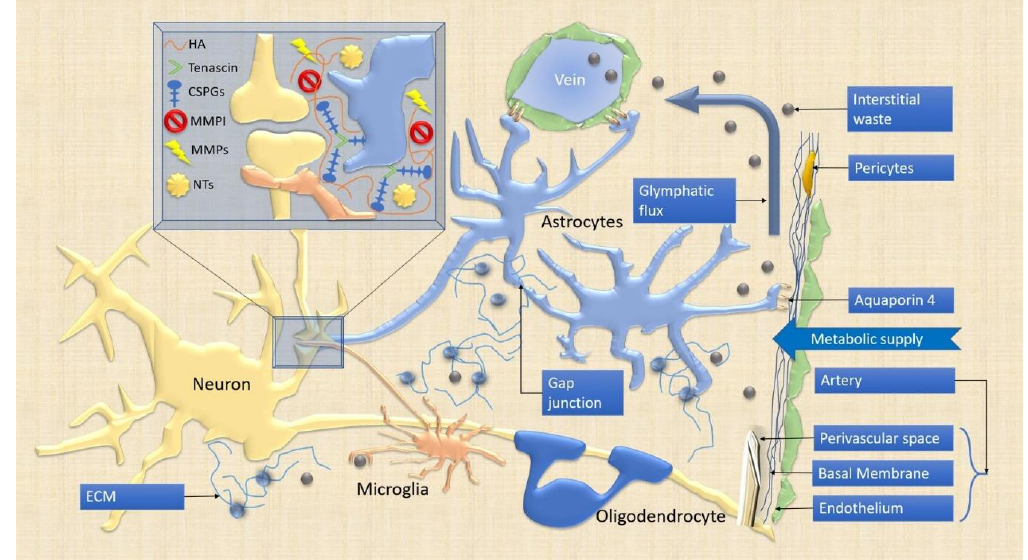
Figure 1. Schematic representation of the synaptic cleft. The main cellular and extracellular components implicated in both physiological and pathological synaptic changes are schematically represented. Oligodendrocytes ensure the correct myelination of the circuits. Microglia constantly scan the microenvironment and remove the debris. From the perivascular space of penetrating arteries, and the neurovascular unit (NVU) elements, fluid dynamics convey waste products toward perivenous spaces and control metabolic supply. The influx-efflux is regulated by Aquaporin-4 (AQP4) water channels densely expressed within astrocyte end-feet. The synaptic cleft magnified in the blue box in the high-left corner encompasses both glial and neuronal elements tightly connected through the extracellular matrix (ECM). The ECM functional sca ff old composed of tenascin, hyaluronic acid (HA) and chondroitin sulfate proteoglycans (CSPGs) regulates the expression of neurotrophins (NTs), matrix metalloproteinases (MMPs), and their inhibitors